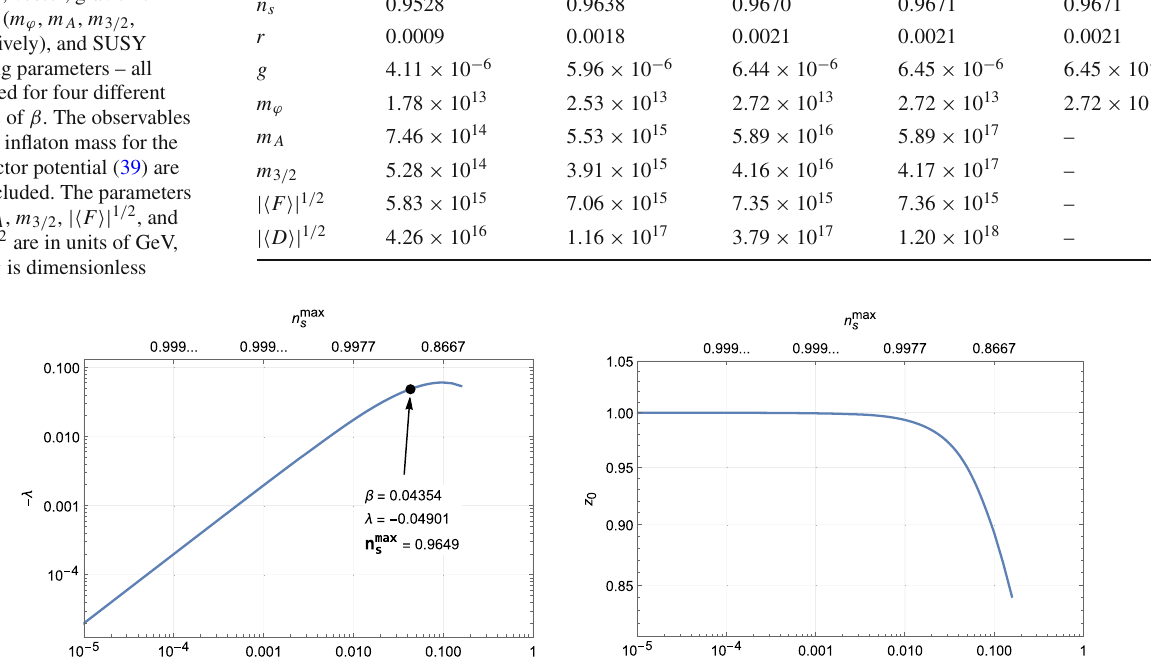
observables n s and r ; the inflaton, vector, gravitino masses ( m ϕ , m A , m 3 / 2 , respectively), and SUSY